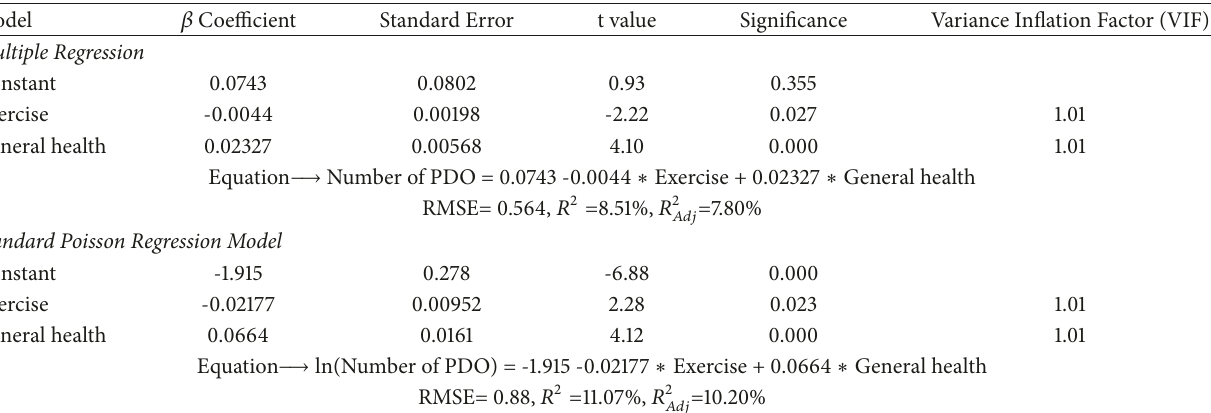
Figure 4: 3D plot for forecasted output: (a) standard Poisson regression and (b) ANFIS-PSO. Table 3: Regression